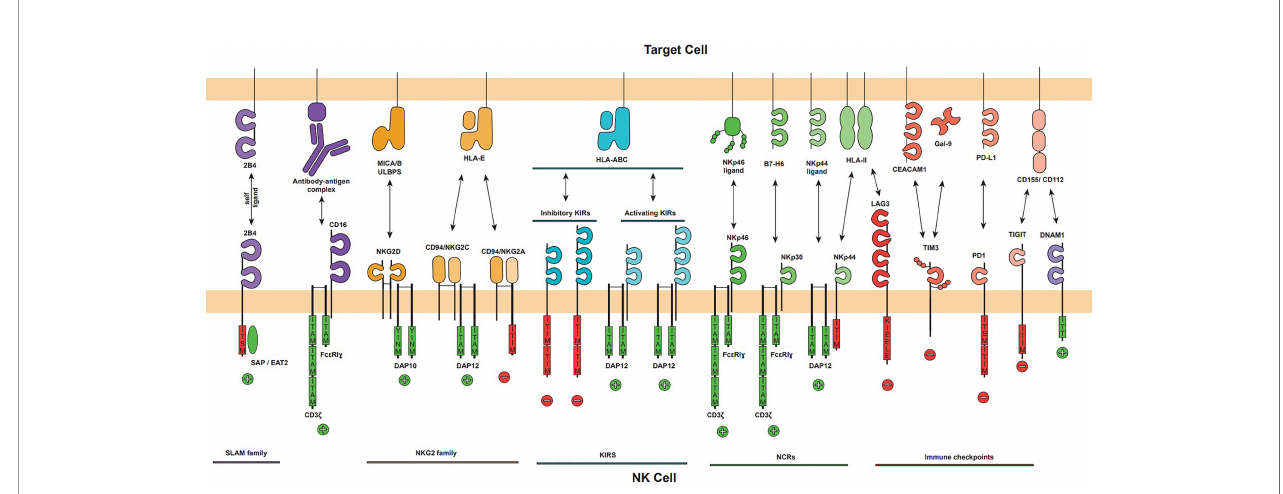
FIGURE 2 | The major activating and inhibitory NK cell receptors and their ligands on target cell. The NK cell activation is mediated by the balance of activating and inhibitory signals that can trigger NK cell effector functions. NK cell receptors families are displayed (NKG2, KIR, NCR and Immune checkpoints) as well as CD16 and DNAM1 activating receptors. Each receptor is represented showing their immunoglobulin-like or lectin-like extracellular domains, its oligomerization (NKG2D homodimer, NKG2A and NKG2C heterodimer with CD94), its associated adapter (DAP10, DAP12 or CD3 z /Fc ϵ RI g ), and their intracellular signalling domains if applicable. Intracellular activator domains (green) ITAM and YINM promote positive activation signals, represented by a plus sign, and inhibitory domains (red) ITIM, KIEELE and ITISM trigger inhibitory signals represented by a minus sign. The major ligands of each receptor are